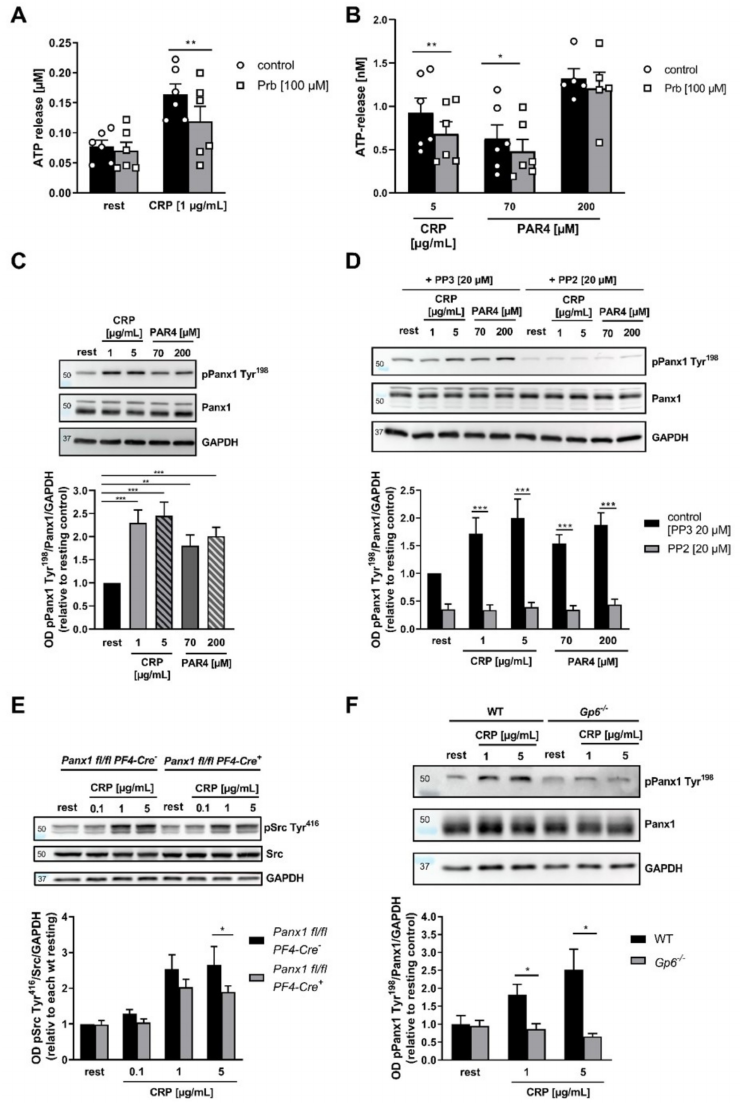
Figure 1. PANX1 represents a platelet ATP channel and is phosphorylated after CRP and PAR4 peptide stimulation of human platelets via Src activation: ( A , B ) Isolated platelets were pre-incubated with the PANX1 inhibitor Prb and ATP release was measured in resting platelets and after activation with ( A ) 1 µ g/mL CRP ( n = 6) via ATP ELISA or ( B ) 1 and 5 µ g/mL CRP ( n = 4–6) and 70 and 200 µ M PAR4 ( n = 4–6) via a luciferin/luciferase bioluminescent assay (aggregometer). ( C – F ) Immunoblotting was performed using isolated platelets activated with indicated concentrations of CRP and PAR4. ( C ) Phosphorylation of PANX1 at Tyr 198 was quantified (n= 8) and ( D ) analyzed after pre-incubation of platelets with the SFK inhibiting compound PP2 or PP3 as a negative control ( n = 6). ( E ) Phos- phorylation of Src at Tyr 416 was analyzed in platelets isolated from Panx1 fl/fl Pf4-Cre + (KO) and Panx1 fl/fl Pf4-Cre − (WT) mice following CRP stimulation ( n = 4). ( F ) Phosphorylation of PANX1 at Tyr 198 was analyzed in platelets from WT and Gp6 − / − mice ( n = 4). Statistical analysis was performed using a two-way ANOVA ( D , E compared to resting; A – C , F , G between groups) followed by a Sidak’s multiple comparisons post-hoc test. Bar graphs indicate mean values ± SEM, * p < 0.05: ** p < 0.01 and *** p < 0.001. Rest = resting, CRP = Collagen-related peptide, PAR4 = Protease-activated receptor 4 peptide, Prb = probenecid, SFK = src family kinase, WT = wild type, KO =